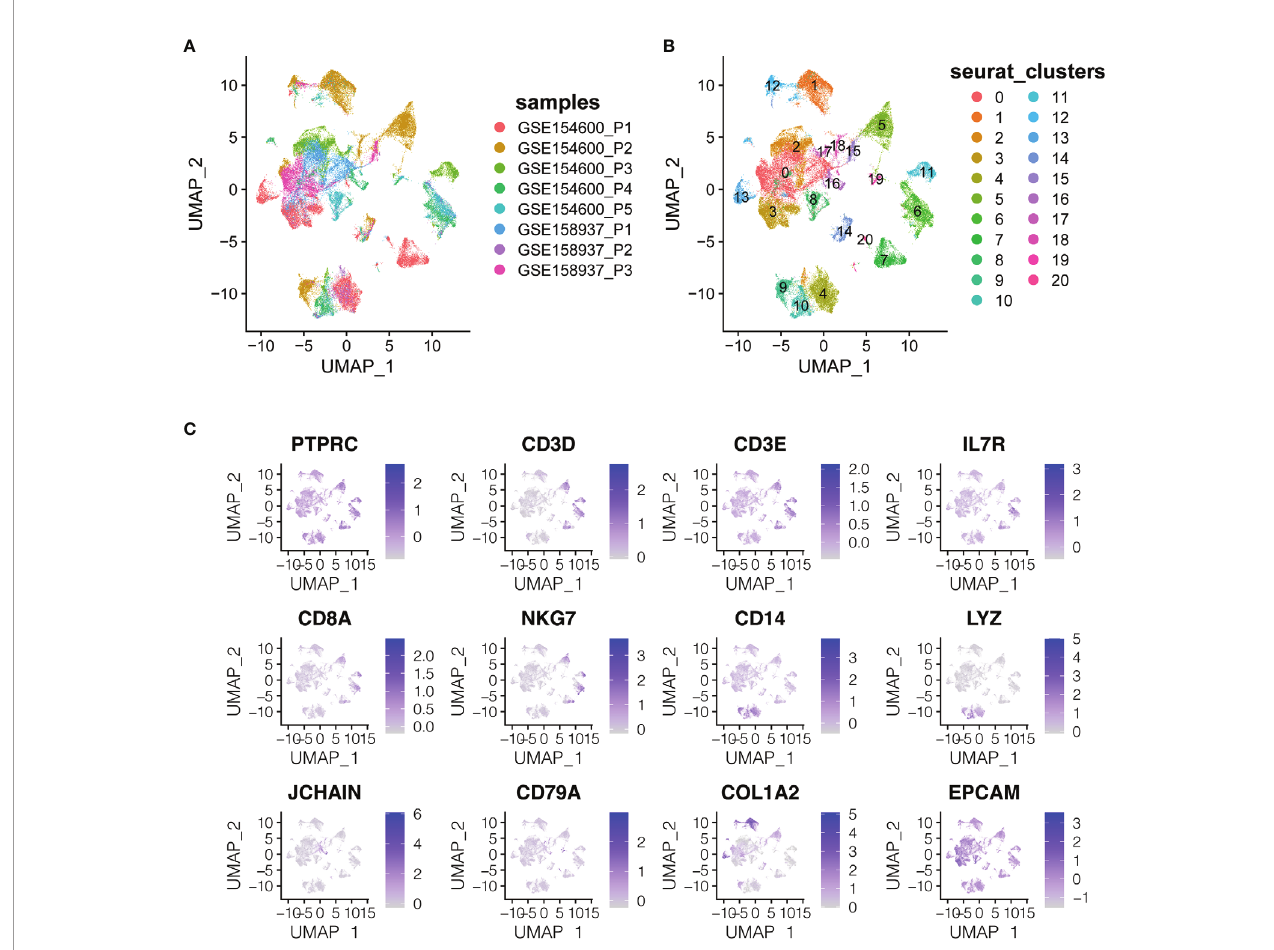
FIGURE 2 | The dimension reduction of OC scRNA-seq. (A) Color depending on different patients. (B) Label colors according to separate clusters. (C) Expression of important marker